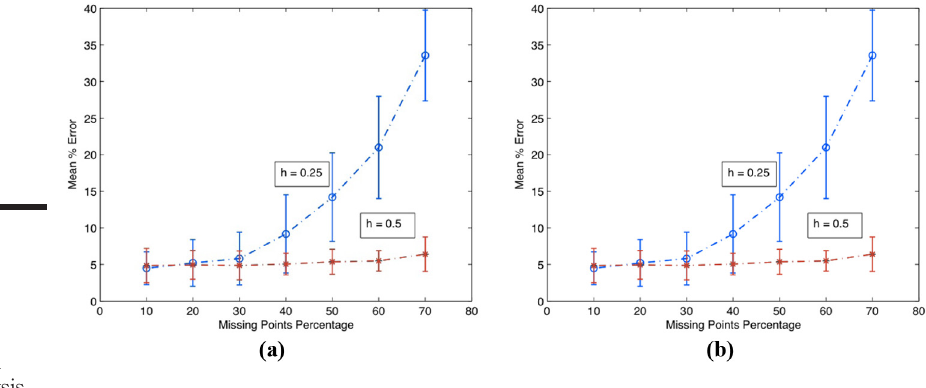
Figure 4. Guassian Kernel regression analysis